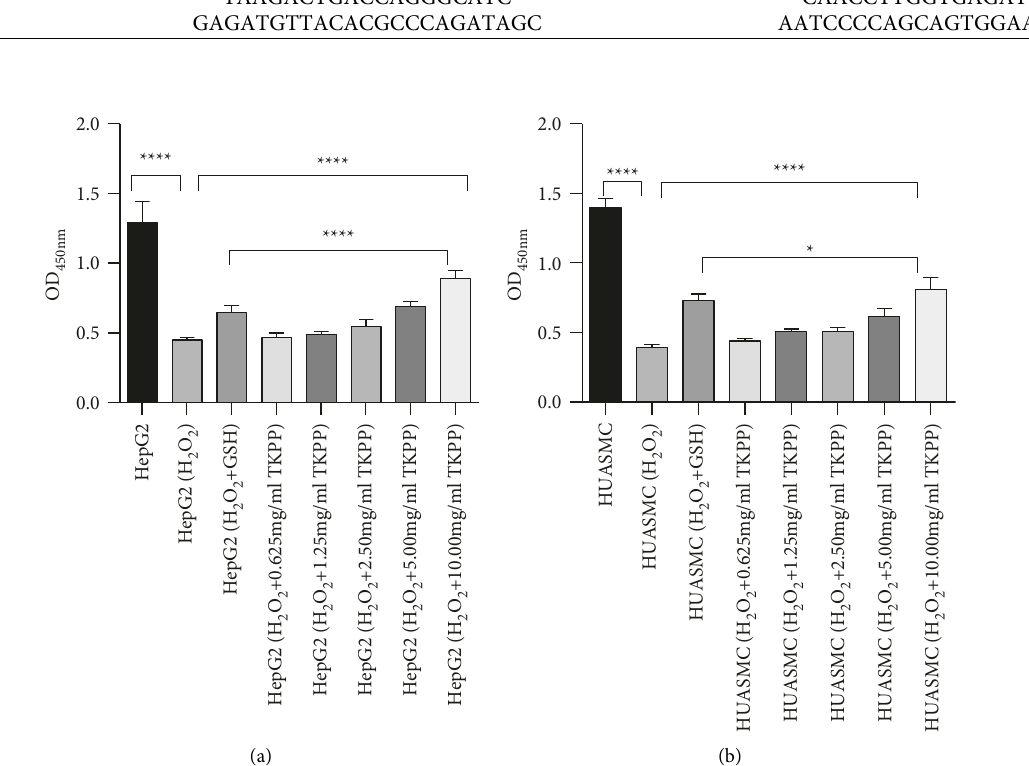
Figure 1: Effects of TKPP with different concentrations on HepG2 (a) and HUASMC (b) cell viability. ∗ P < 0 . 05, ∗∗∗∗ P < 0 . 0001. TKPP could promote the GSH level in H 2 O 2 -damaged cells.